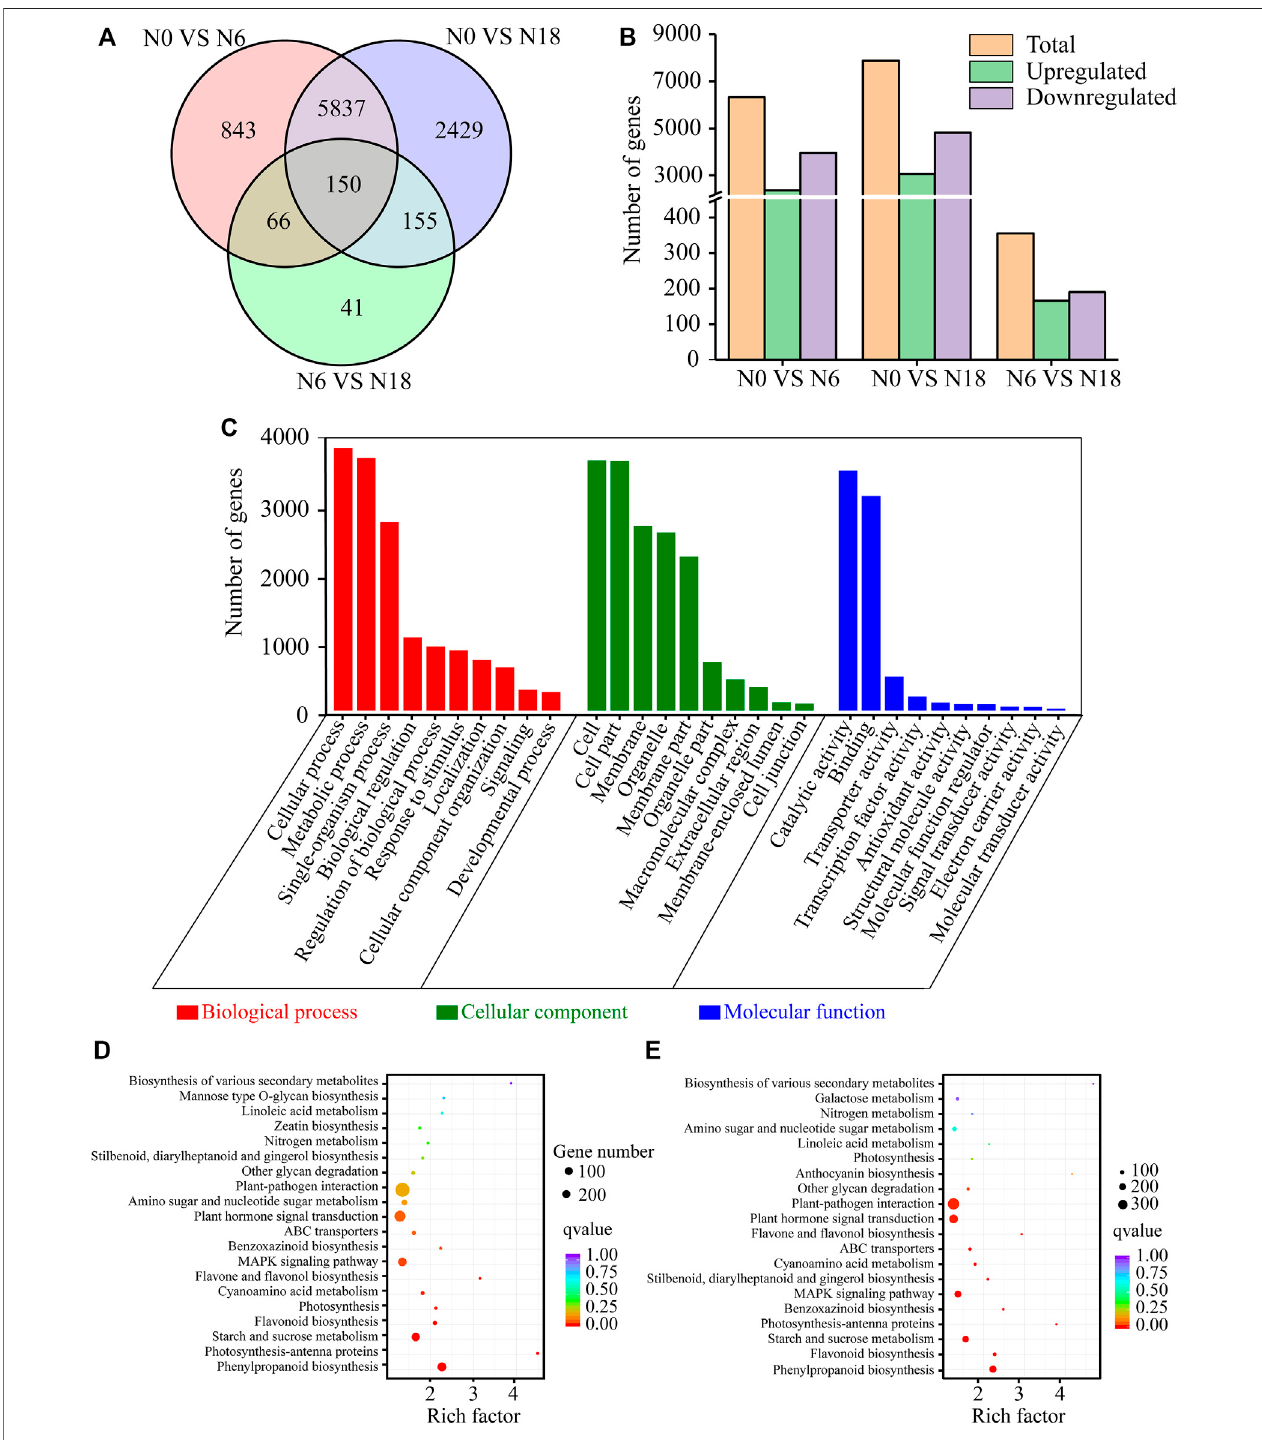
FIGURE 2 | DEGs statistics and functional annotation: (A) Venn diagrams of DEGs; (B) number of upregulated and downregulated genes; (C) GO classi fi cation of DEGs; (D) KEGG enrichment of DEGs from N0 vs . N6; (E) KEGG enrichment of DEGs from N0 vs . N18.